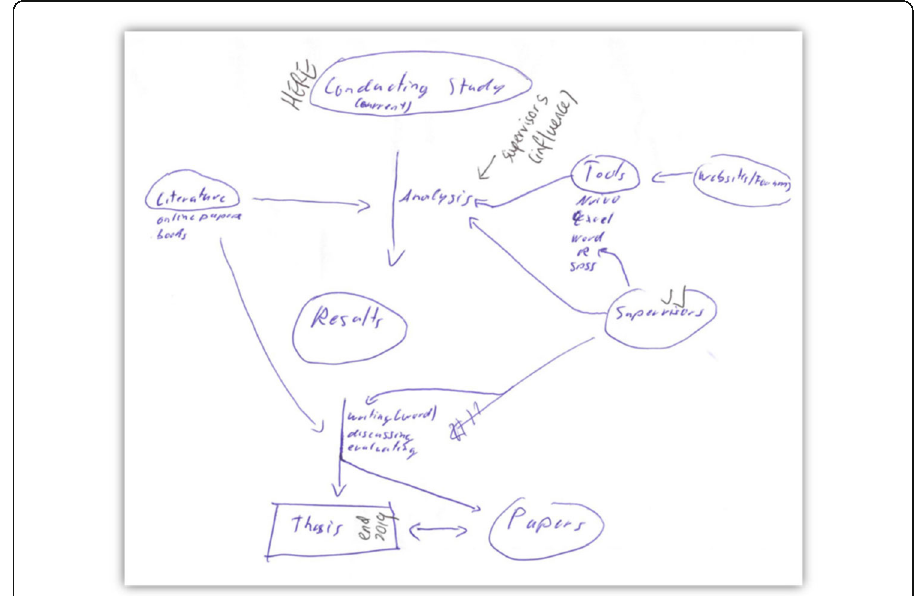
Fig. 1 ICT and people are separate and separated